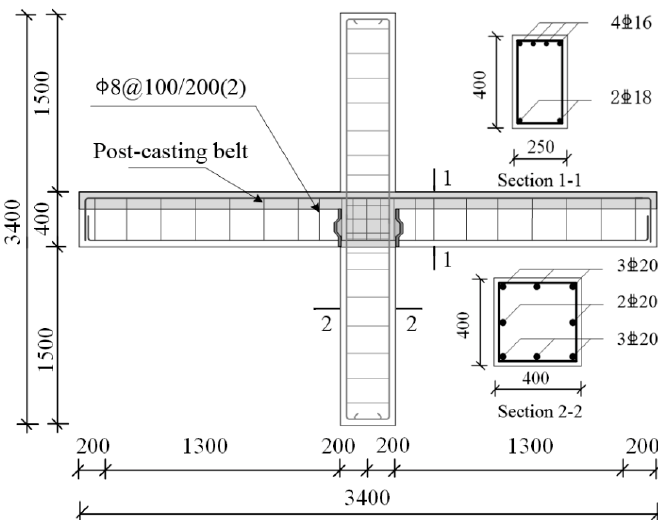
Figure 4. Design dimensions and reinforcement of PC connection.